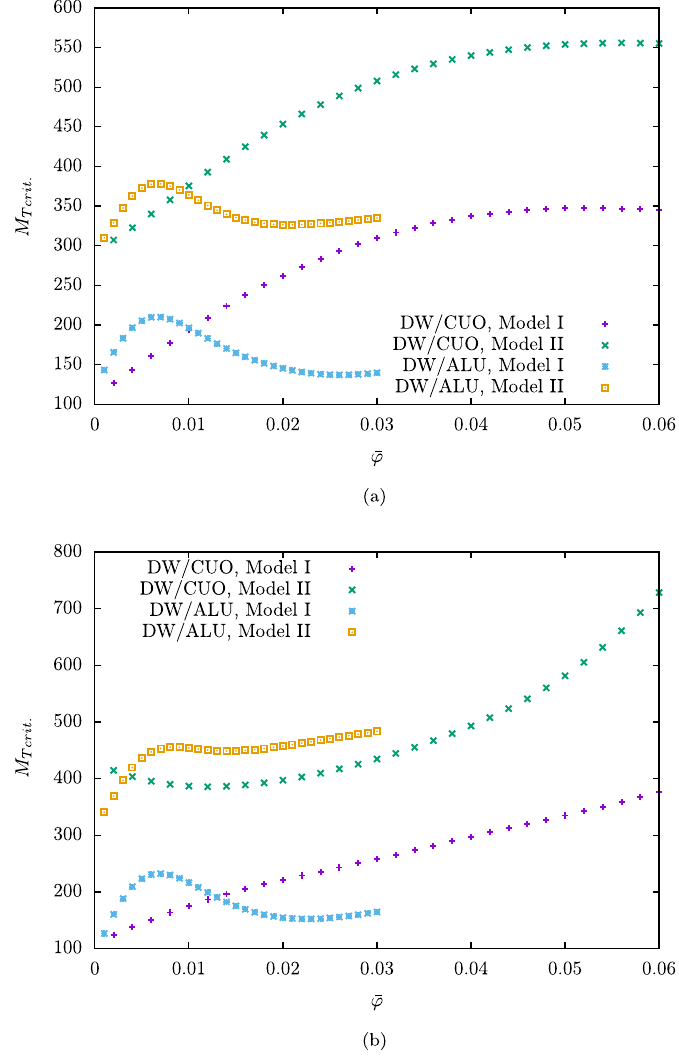
Figure 6: The stability boundaries of critical temperature Marangoni numbers for DW/alumina and DW/cupric oxide nano fl uids based on Model I and Model II with = T 1,000, a using the models proposed by ( a ) Brinkman - Hamilton - Crosser and ( b ) Khanafer and